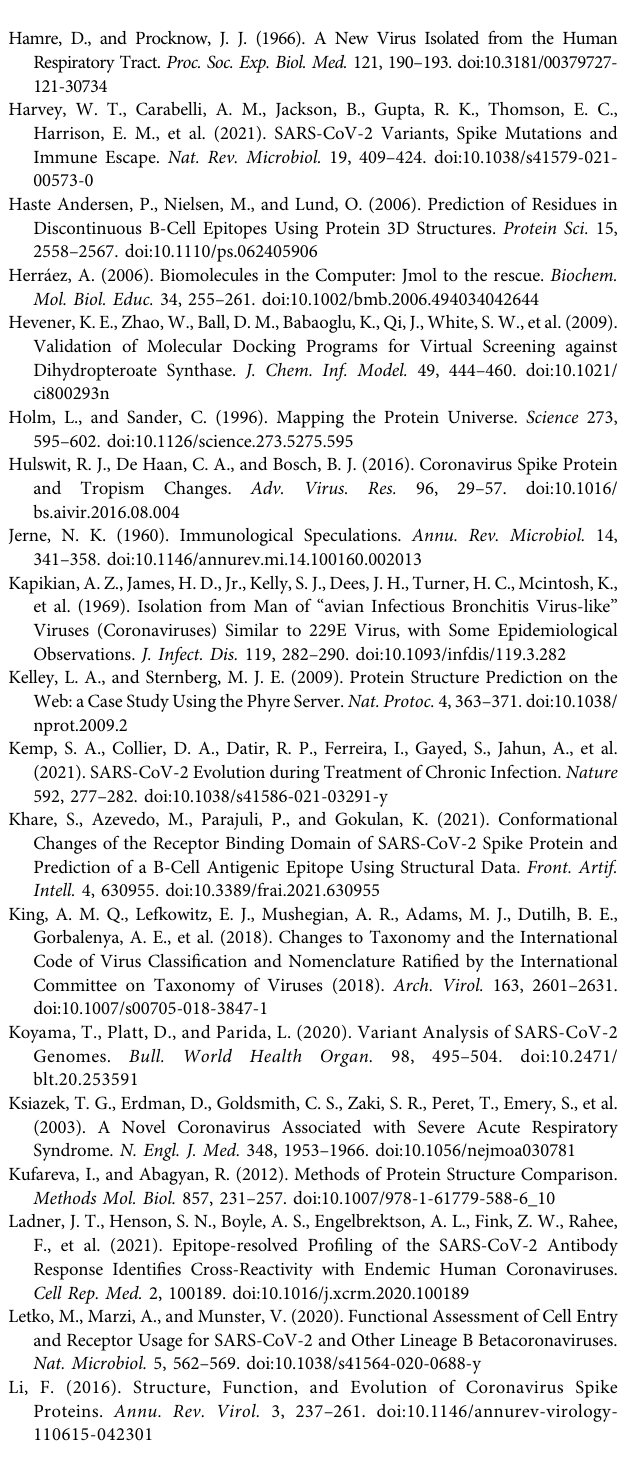
Supplementary Figure S1 | Generated spike homology models related to SARS2 and VOC. (A) original SARS2, (B) alpha variant, (C) beta variant, (D) gamma variant, and (E) delta variant. SupplementaryFigureS2 |Generatedspikehomologymodelsrelatedtoendemic HCoV. (A) HCoV 229E, (B) HCoV OC43, (C) HCoV NL63, (D) HCoV HKU1, (E) SARS CoV, and (F) MERS